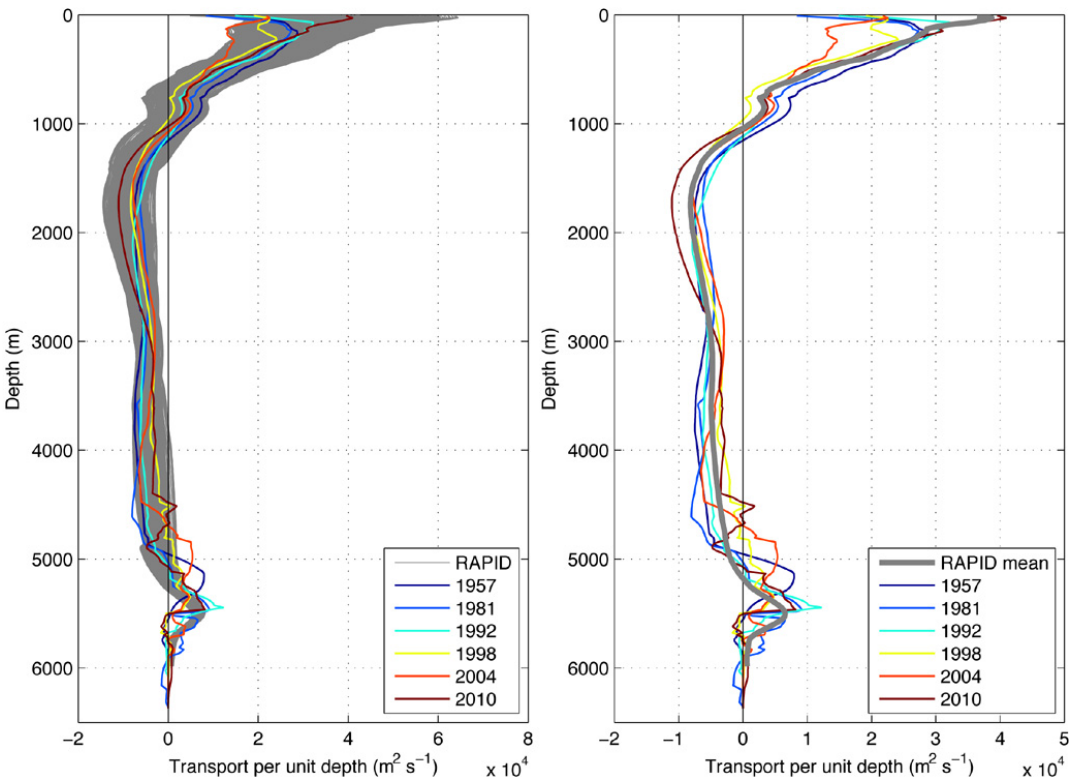
Fig. 5. Profiles of total transport per unit depth (excluding mean surface Ekman transport) for the 6 hydrographic sections and 5 years of Rapid-WATCH data (April 2004–April 2009). Rapid-WATCH data are shown in grey, the grey envelope in the left plot comprises 3562 Rapid-WATCH profiles (available twice daily for 5 years) whilst the grey line in the right plot shows the mean of these profiles. All profiles use long-term mean Florida Straits and Ekman transport, thus, variability represents only that associated with changes in mid-ocean vertical transport